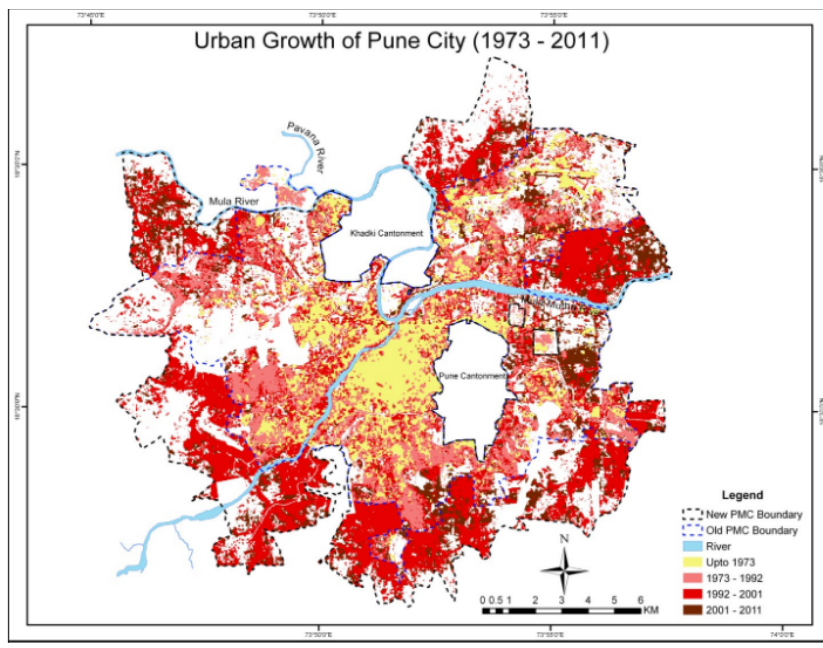
Figure 1. Map of urban growth in Pune city from Mundhe and Jaybhaye (2014). the original moment of their initial separation. As